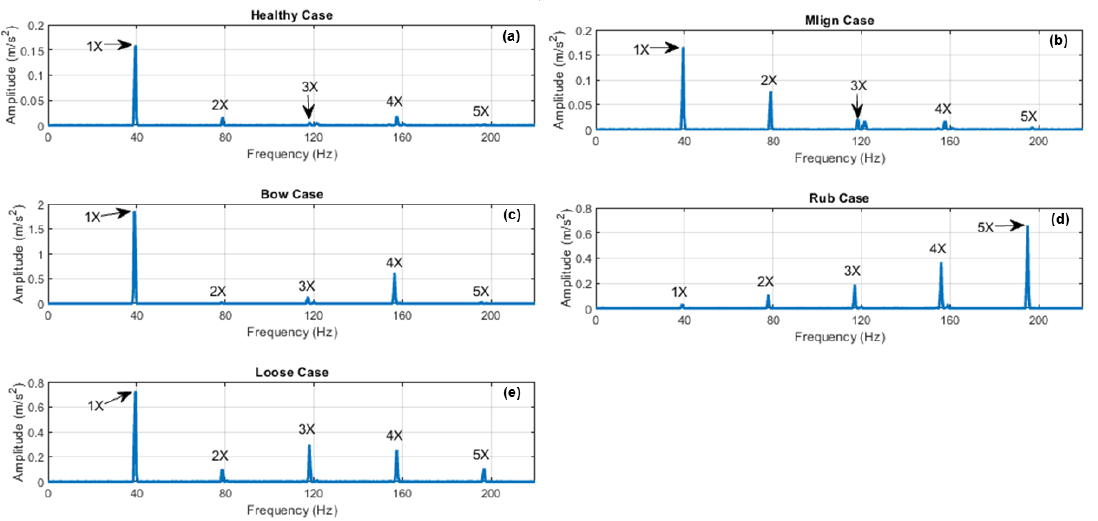
Figure 5. Typical CCS for all cases at 40Hz. ( a ) Healthy; ( b ) Mlign; ( c ) Bow; ( d ) Rub; ( e )